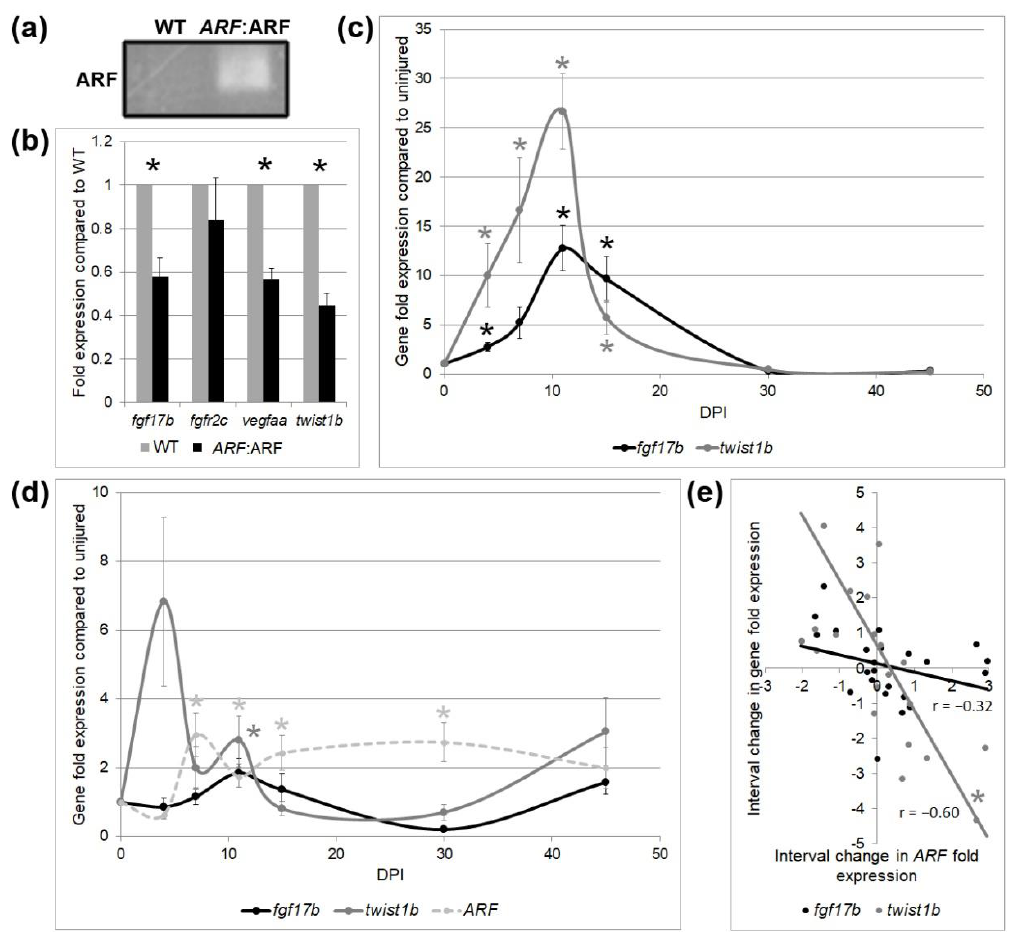
Figure 4. Tissue-specific gene expression by qPCR in WT and ARF :ARF fish over time. ( a ) Representative PCR product of ARF expression from three experimental replicates of WT and ARF :ARF heart RNA. The product run on gel electrophoresis shows ARF expression present in ARF :ARF fish while absent in WT fish at 11 dpi. ( b ) qPCR of fibroblast growth factor 17b ( fgf17b ), fibroblast growth factor receptor 2c ( fgfr2c ), vascular endothelial growth factor Aa ( vegfaa ), and twist1b mRNA expression for WT and ARF :ARF fish at 11 dpi. Results show a significant decrease in the expression of fgf17b , vegfaa , and twist1b in ARF :ARF fish. No significant di ff erence occurred for fgfr2c . N = 8 hearts. ( c ) fgf17b and twist1b mRNA expression for WT fish over time compared to uninjured WT control. fgf17b and twist1b rise steadily after cryoinjury and peak by 11 dpi before tapering down to the uninjured baseline by 30 dpi. N = 18 hearts. ( d ) fgf17b , twist1b , and ARF mRNA expression for ARF :ARF fish over time compared to uninjured ARF :ARF control. ARF is significantly elevated above the uninjured baseline from 7–30 dpi. fgf17b is never elevated above the uninjured baseline. twist1b expression is only elevated above the uninjured baseline on 11 dpi. N = 24 hearts. ( e ) Correlation between interval change in ARF expression with changes in fgf17b and twist1b expression at any time point. ARF expression trended toward inverse correlation with fgf17b expression and was inversely correlated with twist1b expression. N = 24 hearts. Results are shown as mean ± standard error. The * represents a statistically significant difference.